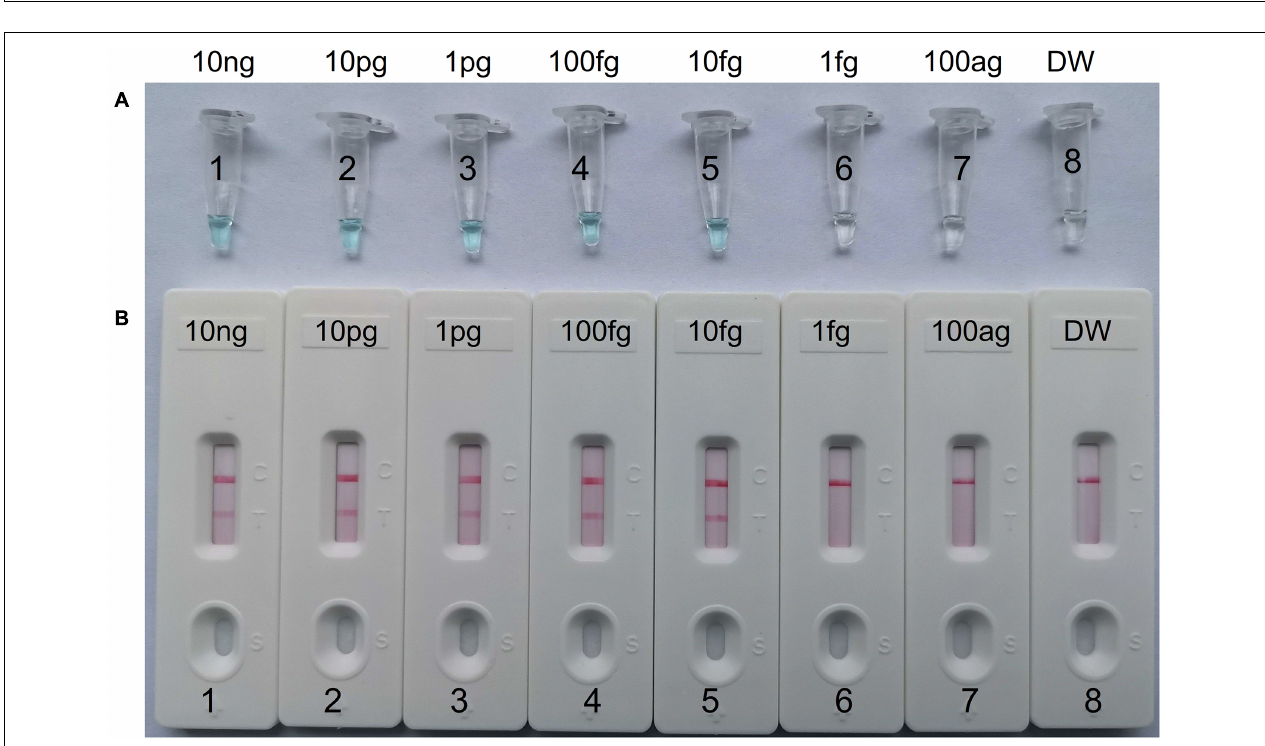
FIGURE 3 | Optimal amplification temperature for C. tropicalis -MCDA assay. By using a real-time measurement to monitor the turbidity of C. tropicalis -MCDA reactions. The corresponding curves were displayed in the panels. The negative control was C. albicans , and the blank control was sterile double-distilled water. Abscissa represents reaction time (min), ordinate represents turbidity. The threshold value was 0.1, and the turbidity > 0.1 was considered as positive amplification. Eight kinetic curves (A–H) were generated from 61 to 68 ◦ C (1 ◦ C intervals), with 10 pg C. tropicalis DNA per reaction. The optimal C. tropicalis -MCDA reaction temperature was 64 ◦ C.